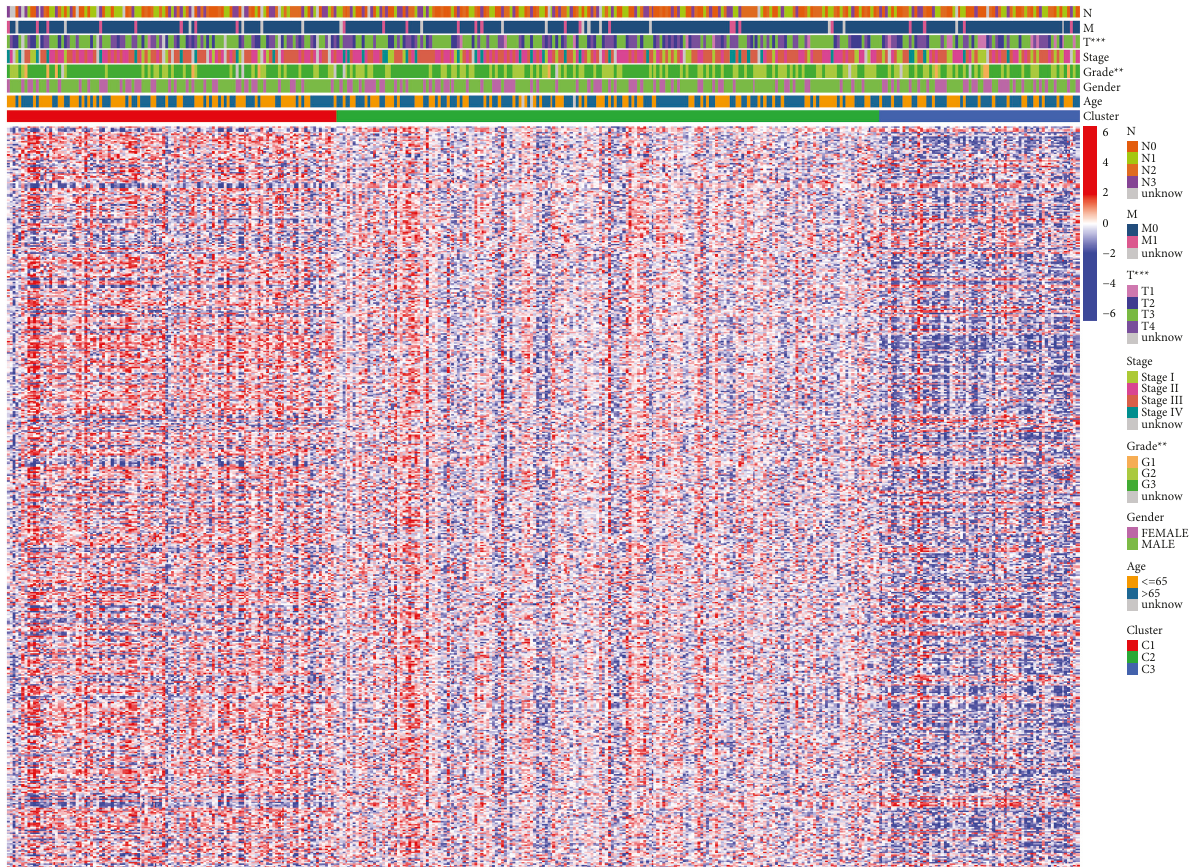
Figure 3: Heatmap of relationship between subtypes and clinical